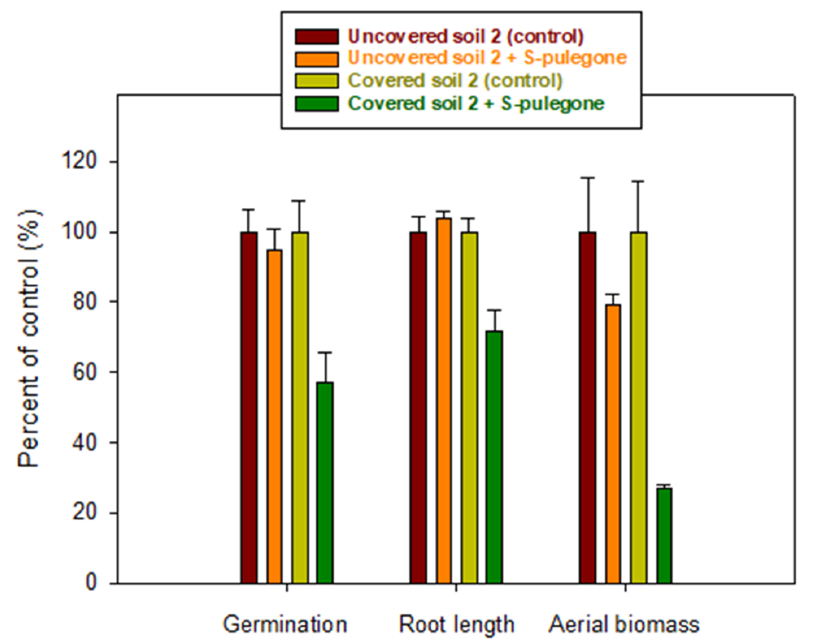
Figure 4. Effect of S ‐ pulegone applied at 12 kg/ha on germination, root length, and aerial biomass of Lactuca sativa sown in pots filled with soil 2. The effect of covering the soil pots with plastic films to reduce volatilization losses of S ‐ pulegone is shown in the graphs. Error bars correspond to the standard errors of triplicate measurements.